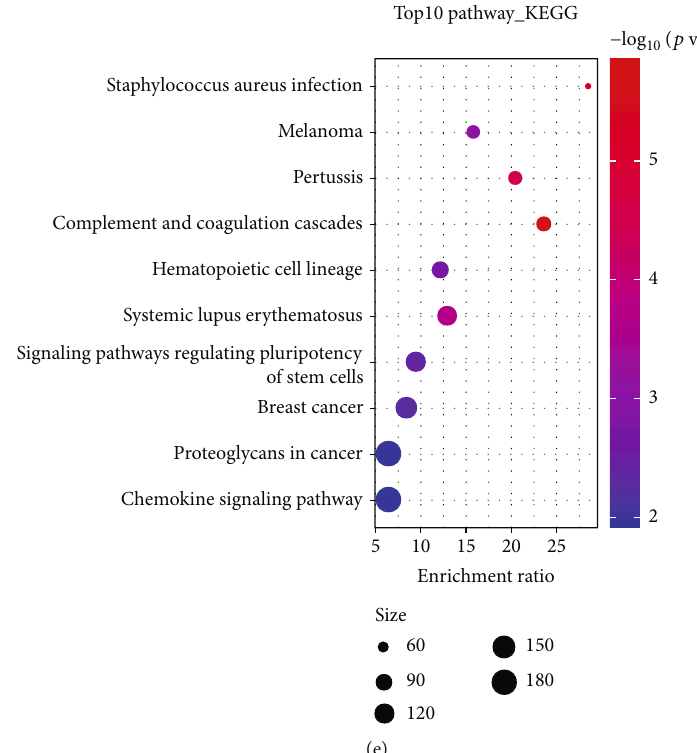
Figure 8: Module and functional analyses. (a) PPI network analysis graph for module Mcode3; (b – e) GO and KEGG functional enrichment analyses for genes in module